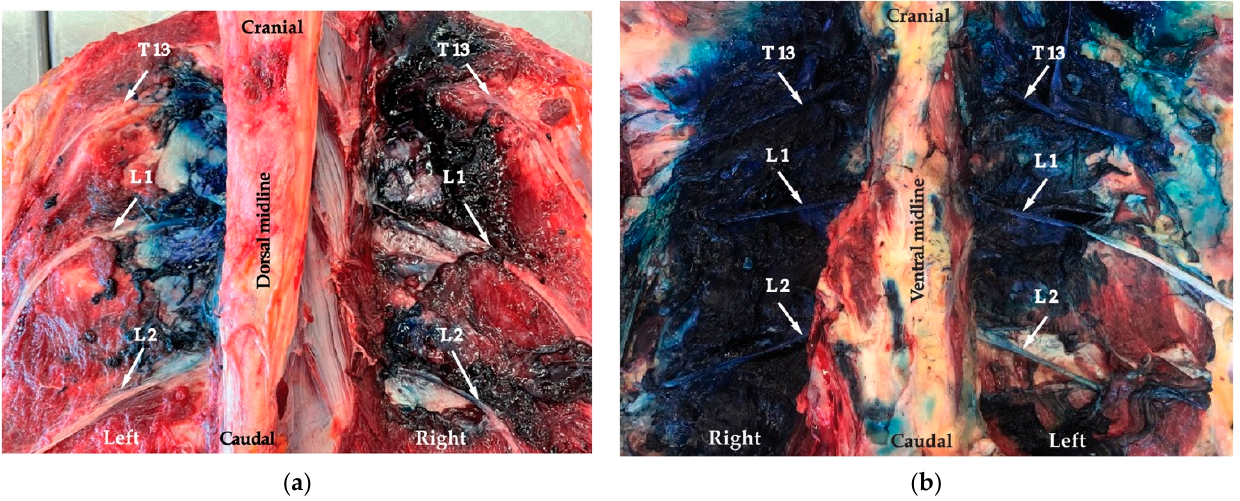
Figure 5. Dissection left side: the ultrasound-guided erector spinae plane block (ESPB) technique and right side: the proximal paravertebral nerve block (PPNB) blind technique. ( a ) Dorsal view: spread of the dye along the nerves (arrows). ( b ) Ventral view: spread of dye along the nerves (arrows).